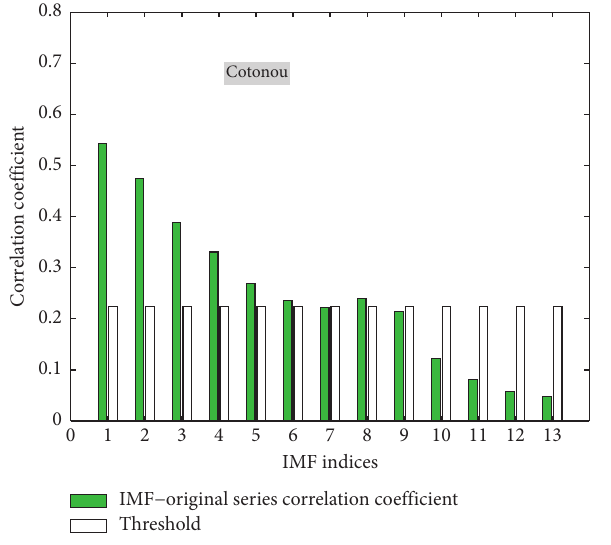
Figure 5: Comparison of Pearson’s correlation coefficient values between IMFs and original data and the threshold values at Cotonou synoptic station. Table 2: Periods (in days) of decomposed data series with EEMD.